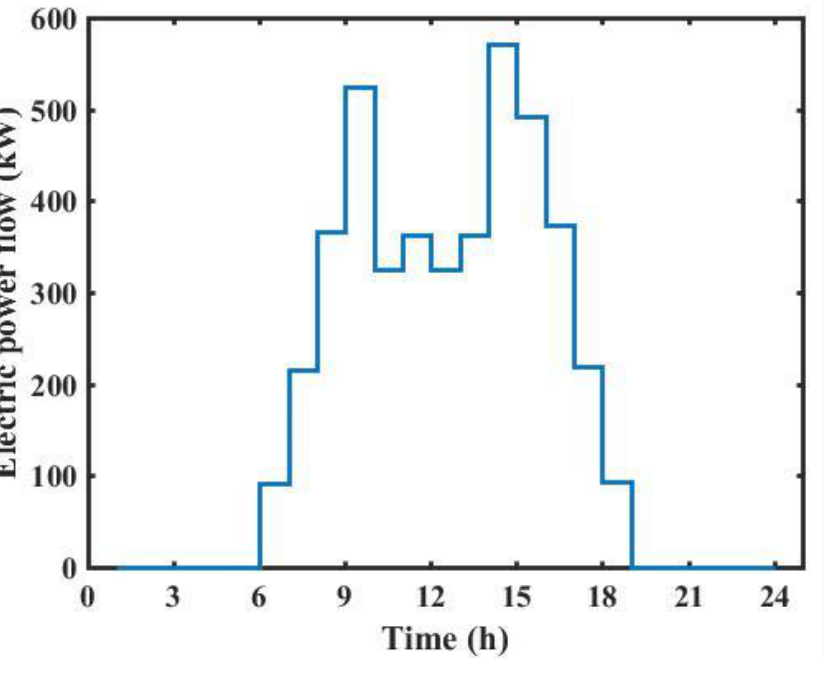
Figure 1. PV generation (kW). The solar radiations are varying with different seasons and cloud movements, which have a direct influence on the PV output. The average solar radiations received by the study area are abundant in the comparison of the world average as its location is proximate to the equator. The average solar radiation and clearness index data is illustrated in Figure 2 where the radiations are maximum in the month of September; however, the clearness index also influences the PV generation during that